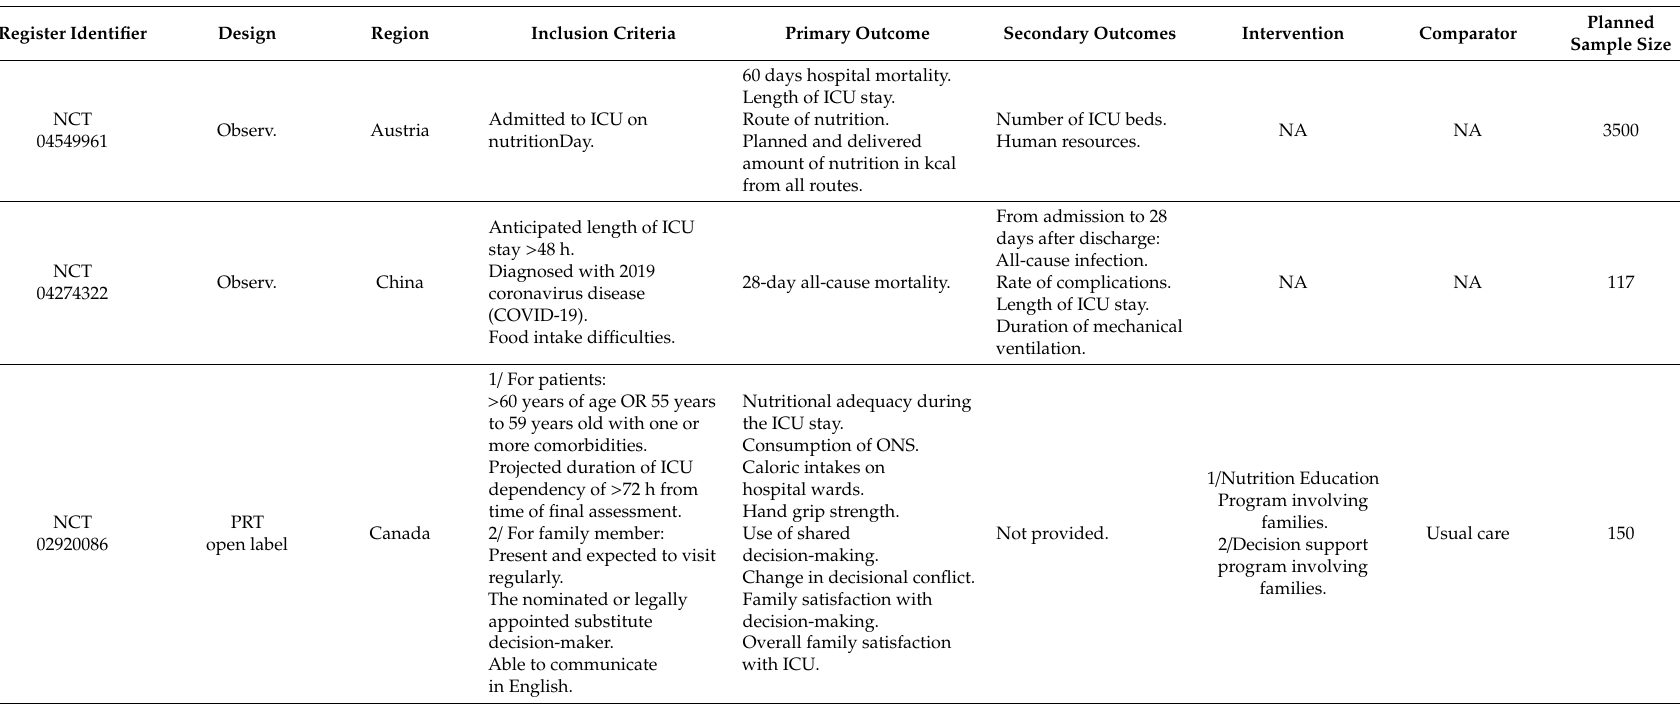
Planned or ongoing studies including, at least partly, adult critically ill patients or survivors on oral nutrition (sources: ClinicalTrials.gov (https: // www.clinicaltrials.gov); EU Clinical Trial Register (https: // www.clinicaltrialsregister.eu); Japan Primary Registries Network including JMACCT (http: // www.jmacct.med.or.jp / en / ctr / ctr_list_p8.html), UMIN (https: // www.umin.ac.jp / ctr / ), and JapicCTI (http: // www.japic.or.jp / ); Australian New Zealand Clinical Trails Registry (https: // anzctr.org.au); ISRCTN registry (https: // www.isrctn.com)—28 October 2020 and 9 November